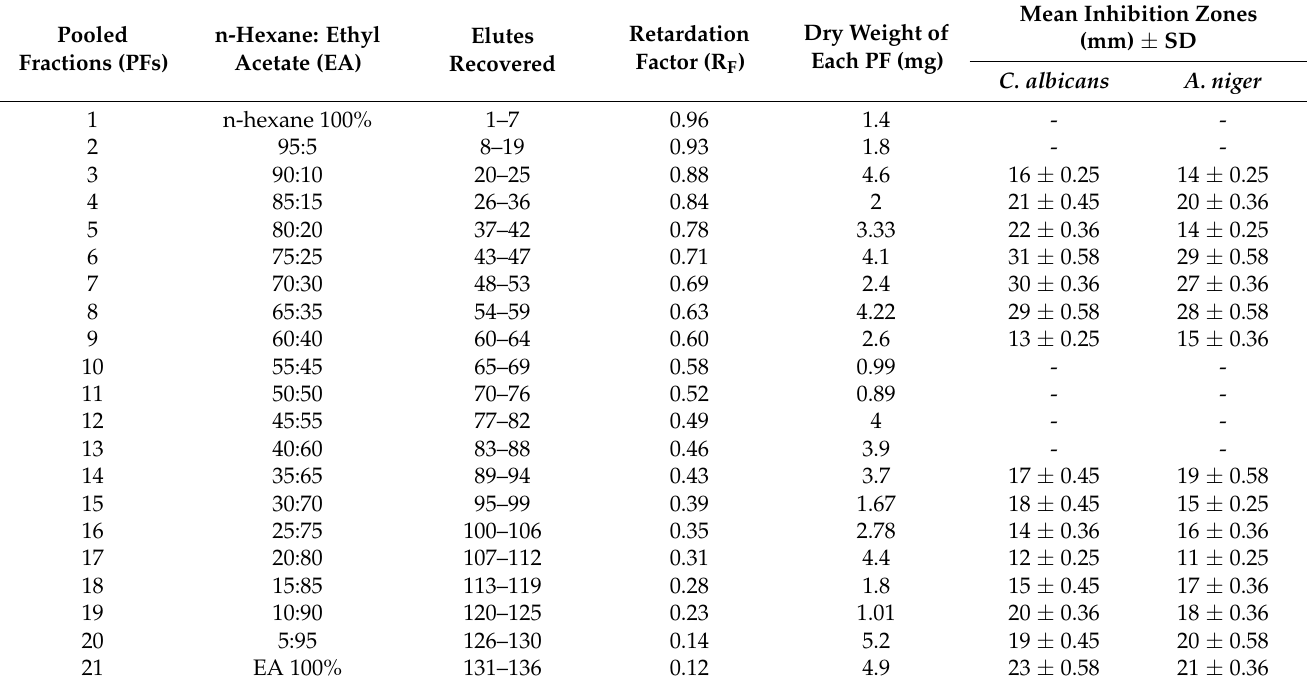
Table 1. Fractionation of crude antifungal metabolite by Lysinibacillus isolate showing ratios of the solvent systems used, the retention factor(s), dry weight(s) and bioautography